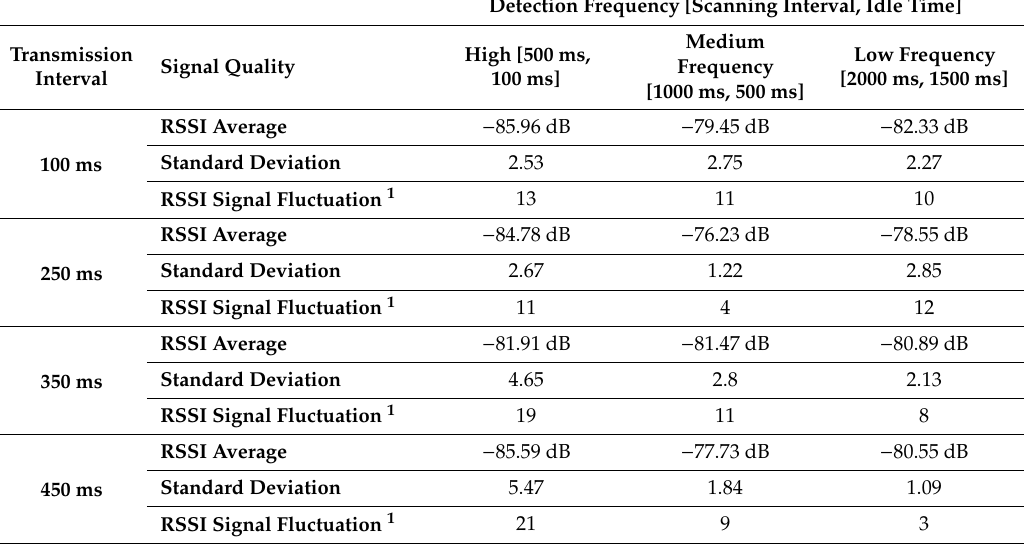
Table 2. Signal quality measurements for di ff erent transmission and scanning interval configurations. RSSI: received signal strength